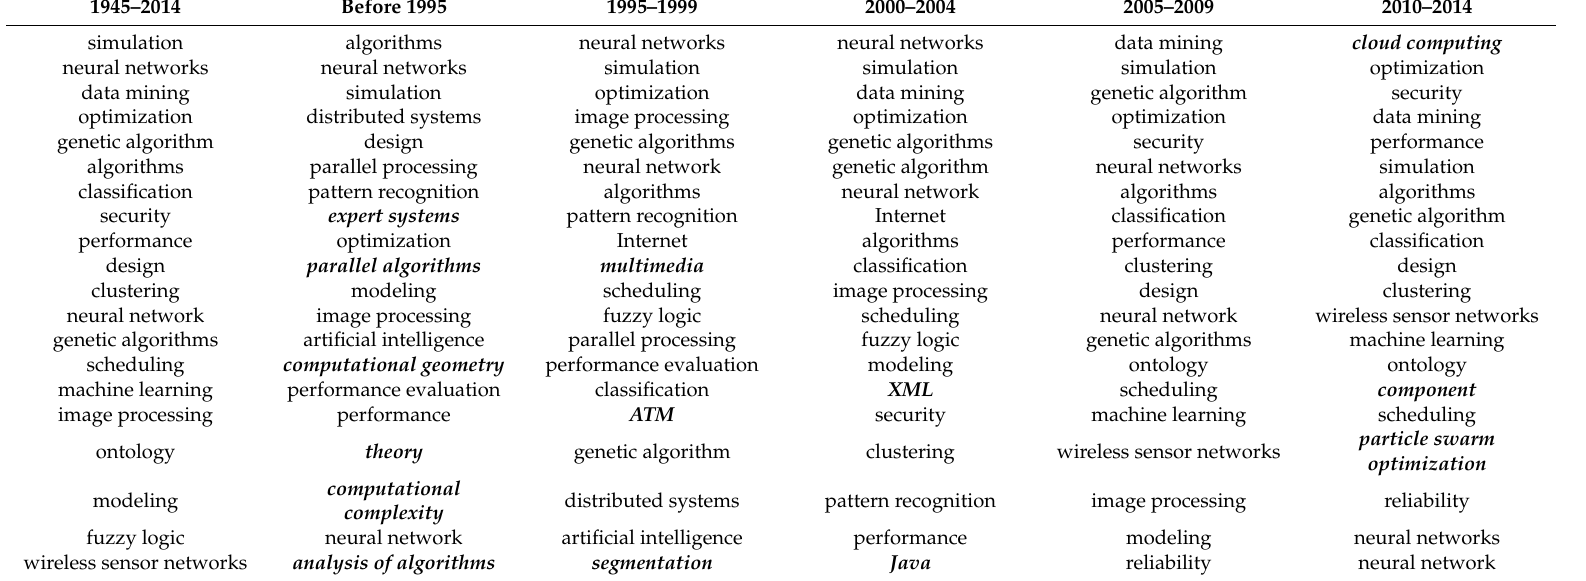
Table 7. Top 20 keywords in the whole period 1945–2014 and in different subperiods with unique keywords